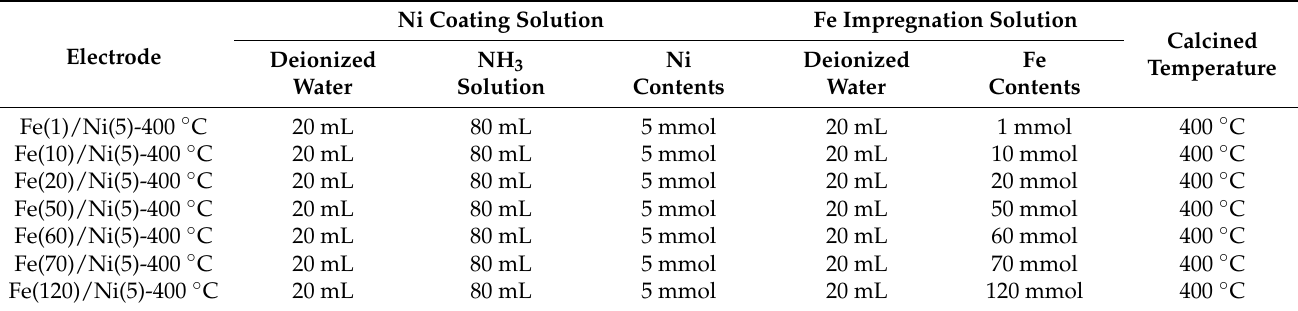
Table 4. Nomenclature of various NiFe electrodes varying with Fe